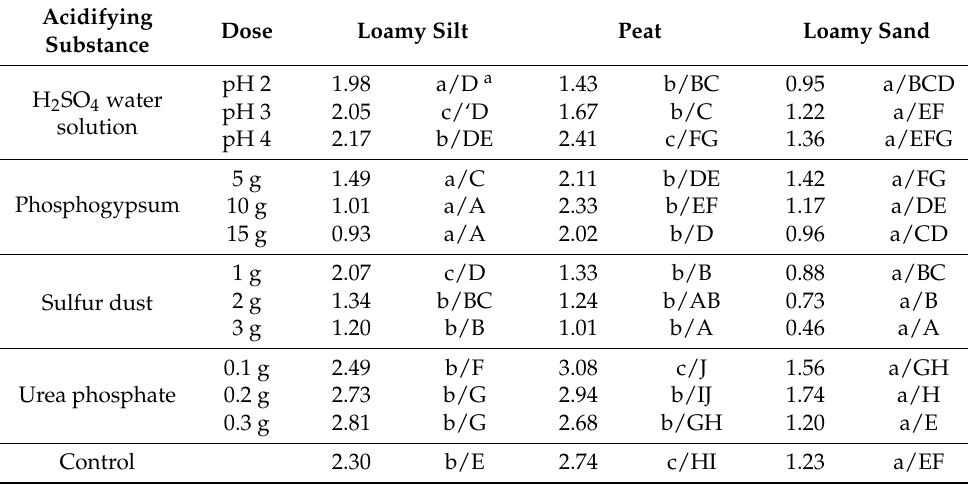
Table 12. Activity of catalytic activity enzyme in the soil depending on the acidifying substances used after 12 months (% O 2 ·